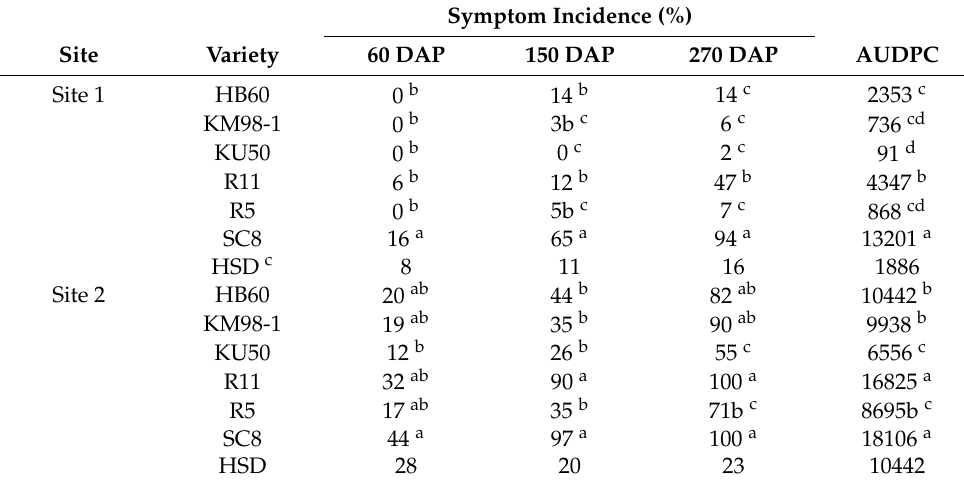
Table 2. Percentage of symptomatic plants (%) by plot and means for disease reactions of cassava varieties evaluated at 2 sites in 2018–2019 season 60, 150 and 270 days after sowing (DAP) and area under disease progress curve (AUDPC). Different letters indicate statistically different means within a given site x